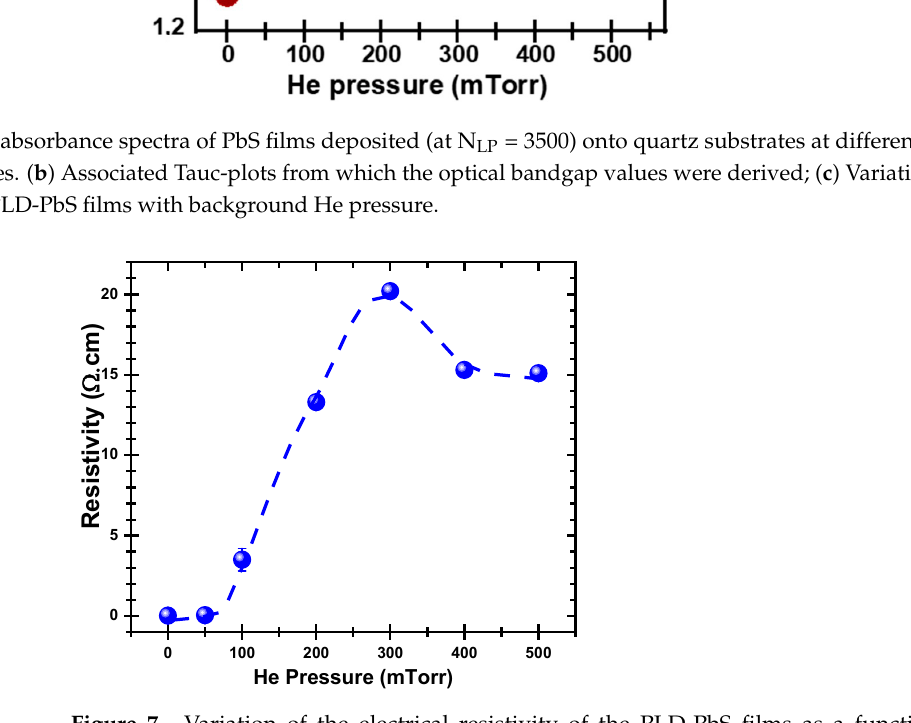
Figure 7. Variation of the electrical resistivity of the PLD-PbS films as a function of the He background pressure.